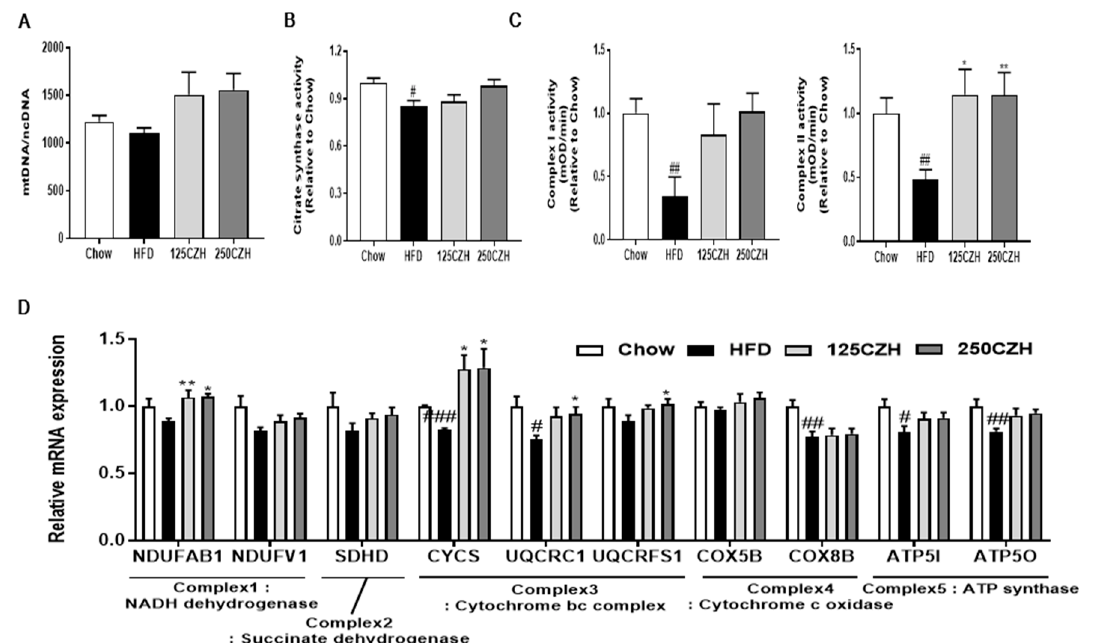
Figure 5. Effect of CZH on mitochondrial dysfunction in obese mice. ( A ) Mitochondrial DNA (mtDNA) content, (B) citrate synthase activity in quadriceps muscle of the mice. ( C ) Complex I and Complex II enzyme activities in gastrocnemius muscle of the mice. ( D ) Relative transcript levels in quadriceps muscle of genes encoding proteins involved in OXPHOS. Results are expressed as mean ± SEM ( n = 8). * p < 0.05, ** p < 0.01, *** p < 0.001 versus the HFD group. # p < 0.05, ## p < 0.01, ### p < 0.001 vs. the Chow-fed group.